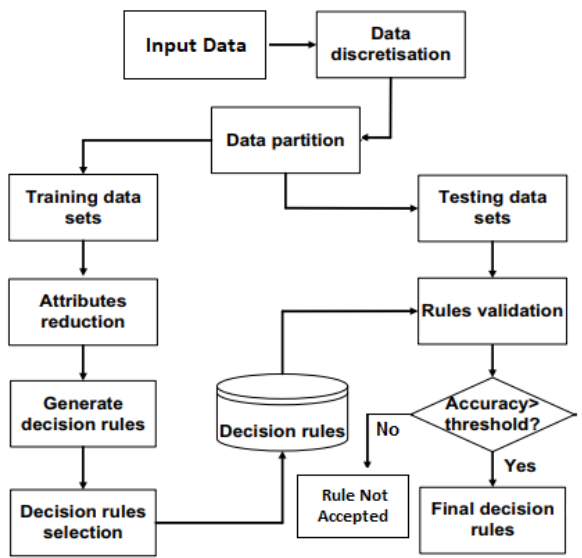
Figure 3. Flow chart of Rough Set Theory decision rules generation.